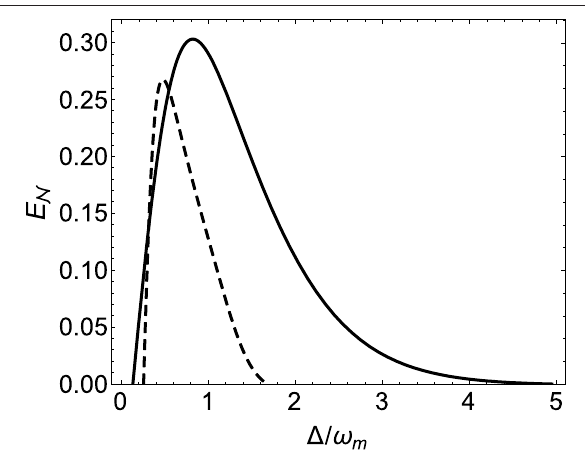
FIGURE 4 | Logarithmic negativity E N as a function of the normalization detuning Δ / ω m for different masses of oscillators. The solid line refers to m (cid:1) 5 p 10 − 9 kg, the mass corresponding to the dash line is m (cid:1) 10 p 10 − 9 kg, and for the dotted line, m (cid:1) 15 p 10 − 9 kg. The temperature is T = 0.4 K.